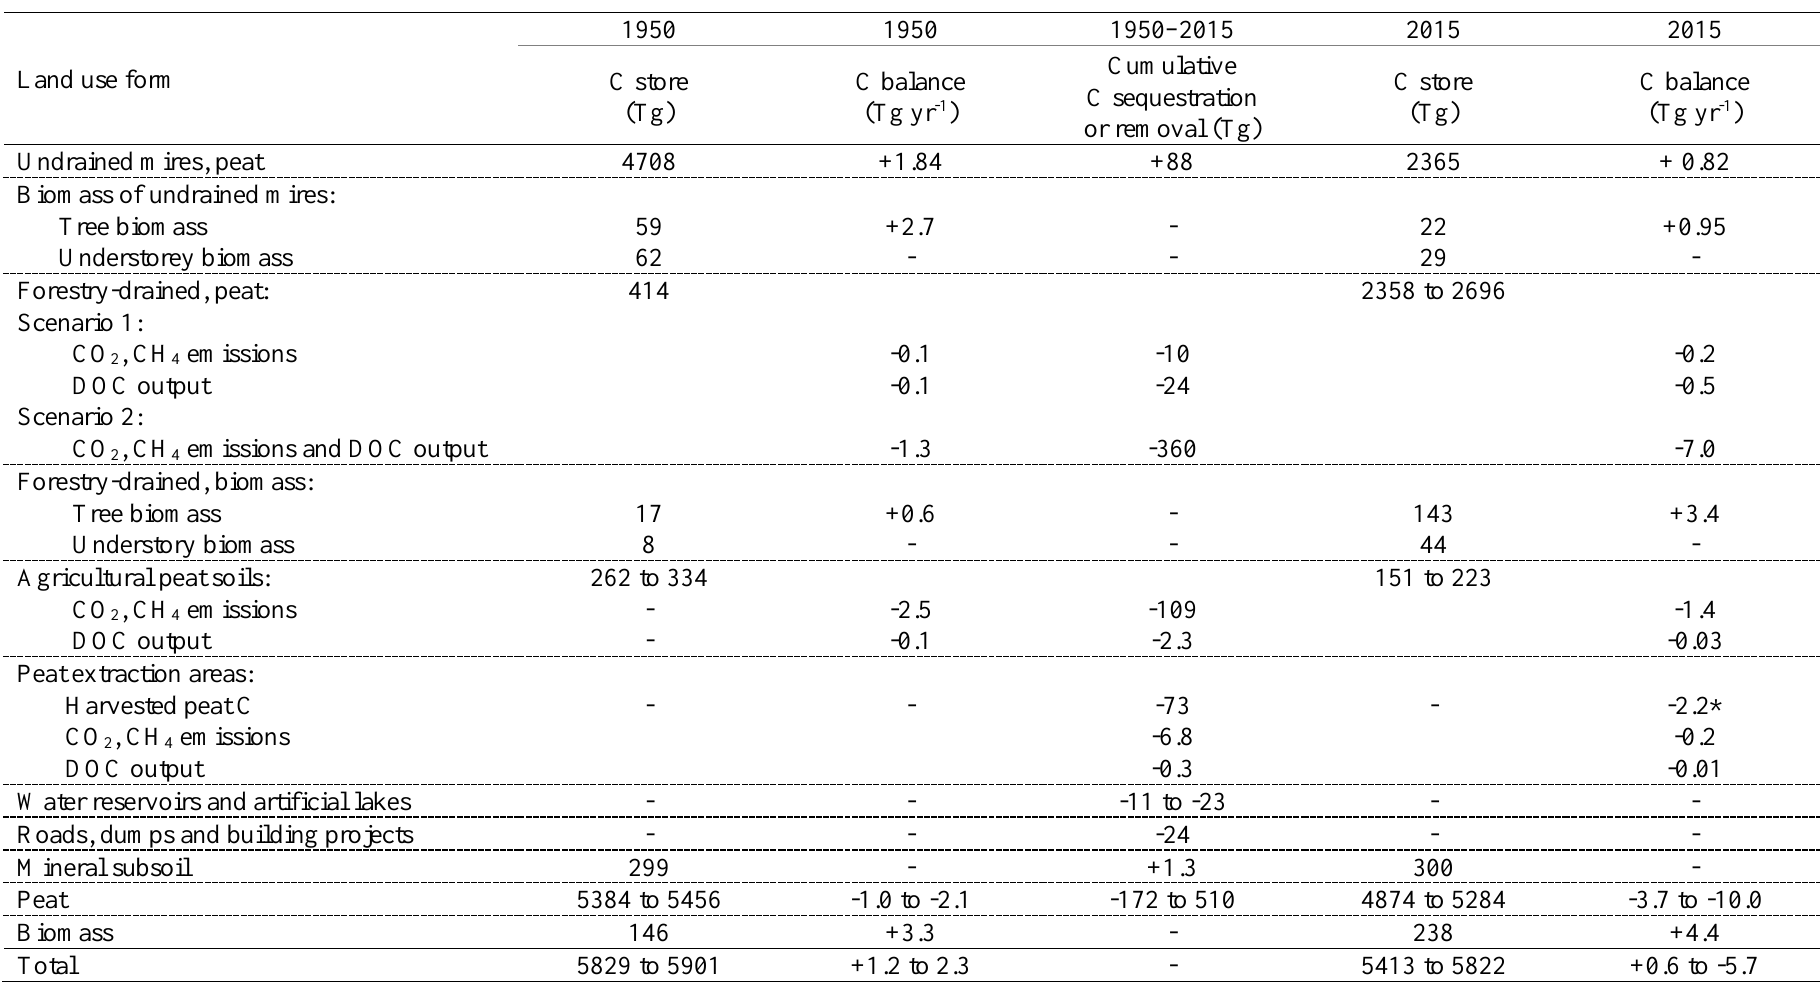
Table 2. Estimated carbon (C) store, C sequestration (+) and C removal (-) of Finnish peatlands from 1950 to 2015. The C balance 2015 of different land use forms is also shown. * = Average 1990–2015 due to seasonal peat extraction